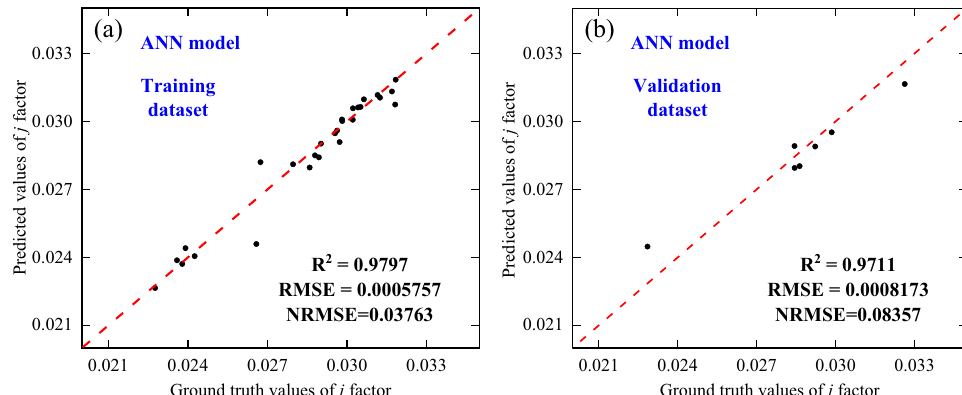
Figure 6 Comparison of predicted and simulated values of j factor